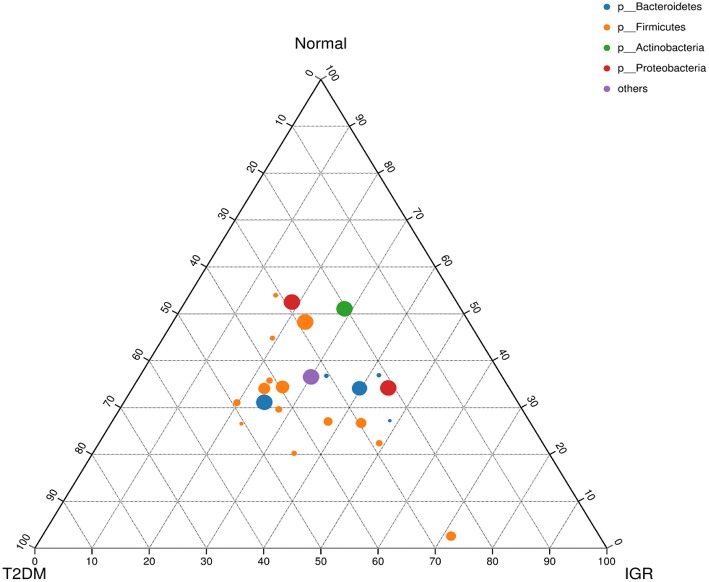
Ternary chart of three groups. Three angles represent three groups, colored circle in the triangle represents species at phylum level, and smaller circle represent species at genus level, the size of the circle represent the relative abundance of the species.